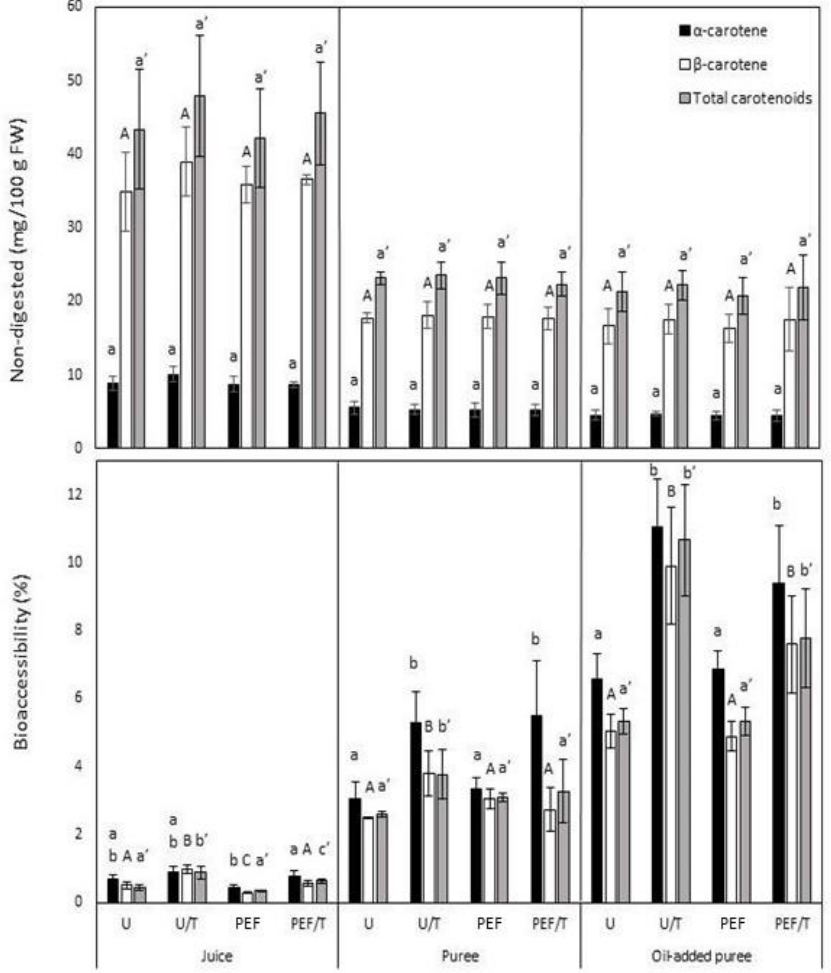
Figure 2. The carotenoid content and bioaccessibility of untreated purees and juices (U), those obtained from PEF-treated (0.61 kJ kg − 1 ) carrots (PEF), and those thermally treated (10 min at 70 ◦ C) (U/T and PEF/T). Values are means ± standard deviation. Different letters within the same product and compound indicate significant ( p < 0.05) differences among treatments ( α -carotene: lowercase letters; β -carotene: uppercase letters; and total carotenoids: lowercase′).